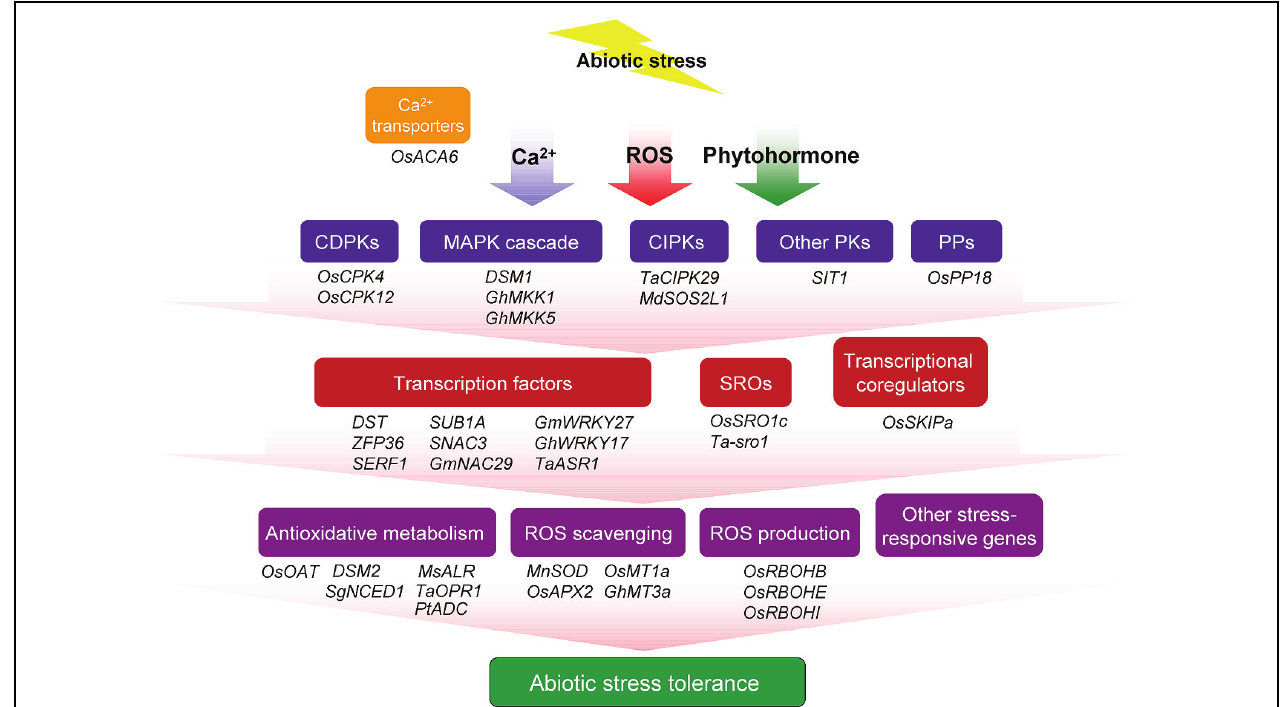
FIGURE 1 | Overview of major genes that involved in abiotic stress resistance through ROS regulation in crop plants. Plant cells perceive abiotic stress signals and transduce them through various signaling pathways including secondary signaling molecules, plant hormones, and transcriptional regulators. The regulation of gene expression by different transcription regulators results in the induction of various defense pathways, such as, reactive oxygen species (ROS) scavenging and antioxidative metabolism. Transcription regulators also mediate ROS producing systems and activate the expression of stress-responsive gene so as to confer tolerance to the environmental stresses. CDPK, calcium-dependent protein kinase; CIPK, calcineurin B-like protein-interacting protein kinase; MAPK, mitogen-activated protein kinase; PK, protein kinase; PP, protein phosphatase; SRO, similar to RCD one.